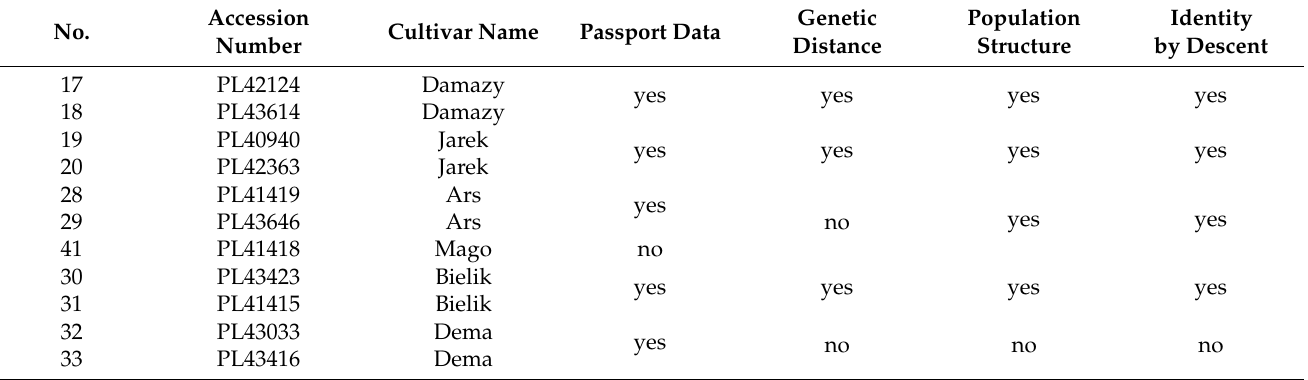
Figure 11. Circular overview of seven H. vulgare chromosomes. ( a ) Transformed FST 10 for cultivars bred before 1945 and after 2000; ( b ) Average polymorphism information content (PIC) distribution in cultivars bred before 1945; ( c ) Average polymorphism information content (PIC) Distribution in cultivars bred after 2000; ( d ) Number of unique SNPs in cultivars bred before 1945; ( e ) Number of unique SNPs in cultivars bred after 2000. A sliding window approach with 500 kb windows, printed for 250 positions along the full length of barley chromosomes based on the genome assembly: IBSC_v2 [21]. Table 5. List of duplicate accessions verified from passport data and DArTseq analysis